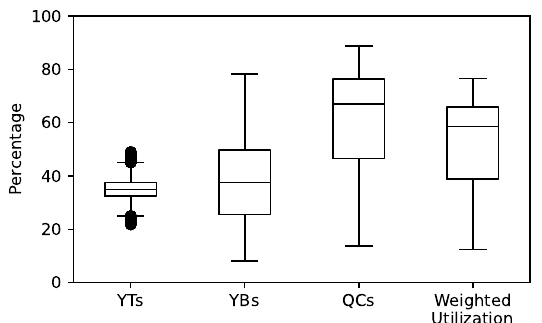
Figure 6. The utilization of the equipment over all